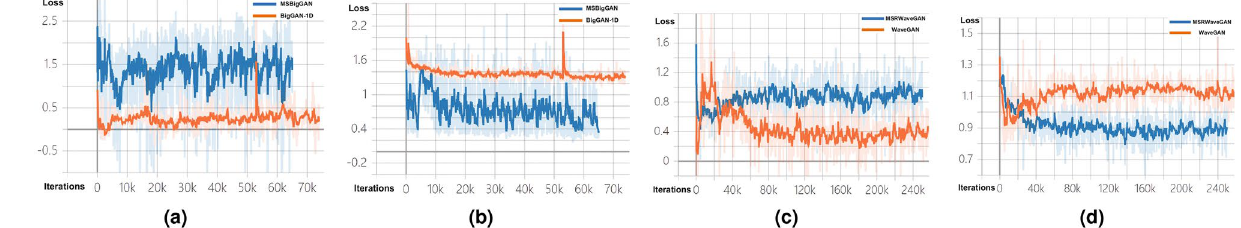
Figure 5. The loss curves of the discriminators and generators. ( a ) Generator loss of BigGAN and MSBigGAN. ( b ) Discriminator loss of BigGAN and MSBigGAN. ( c ) Generator loss of WaveGAN and MSRWaveGAN. ( d ) Discriminator loss of WaveGAN and MSRWaveGAN. The smoothing function is used, and the smoothing factors are set to 0.8 in all